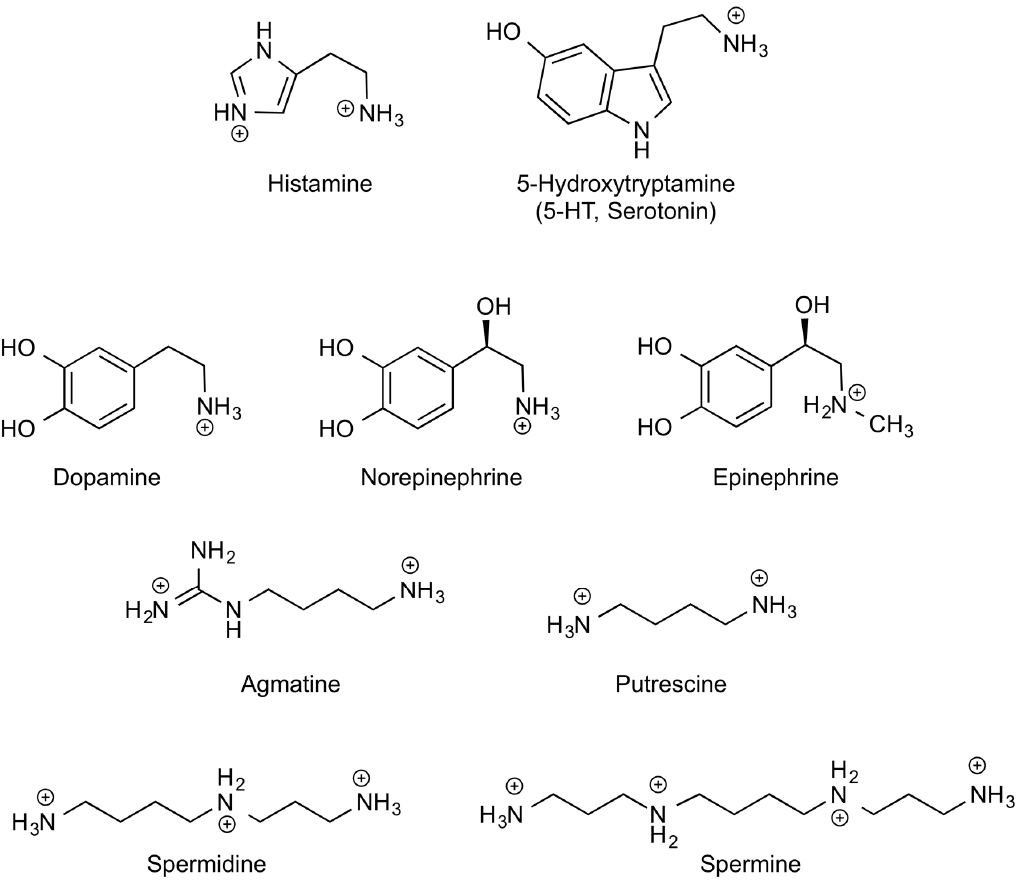
Figure 1. Chemical structures of B/A-BAs in their major forms at physiological pH. Histamine imidazole group is only partially protonated at pH 7 (pI ≈ 6).